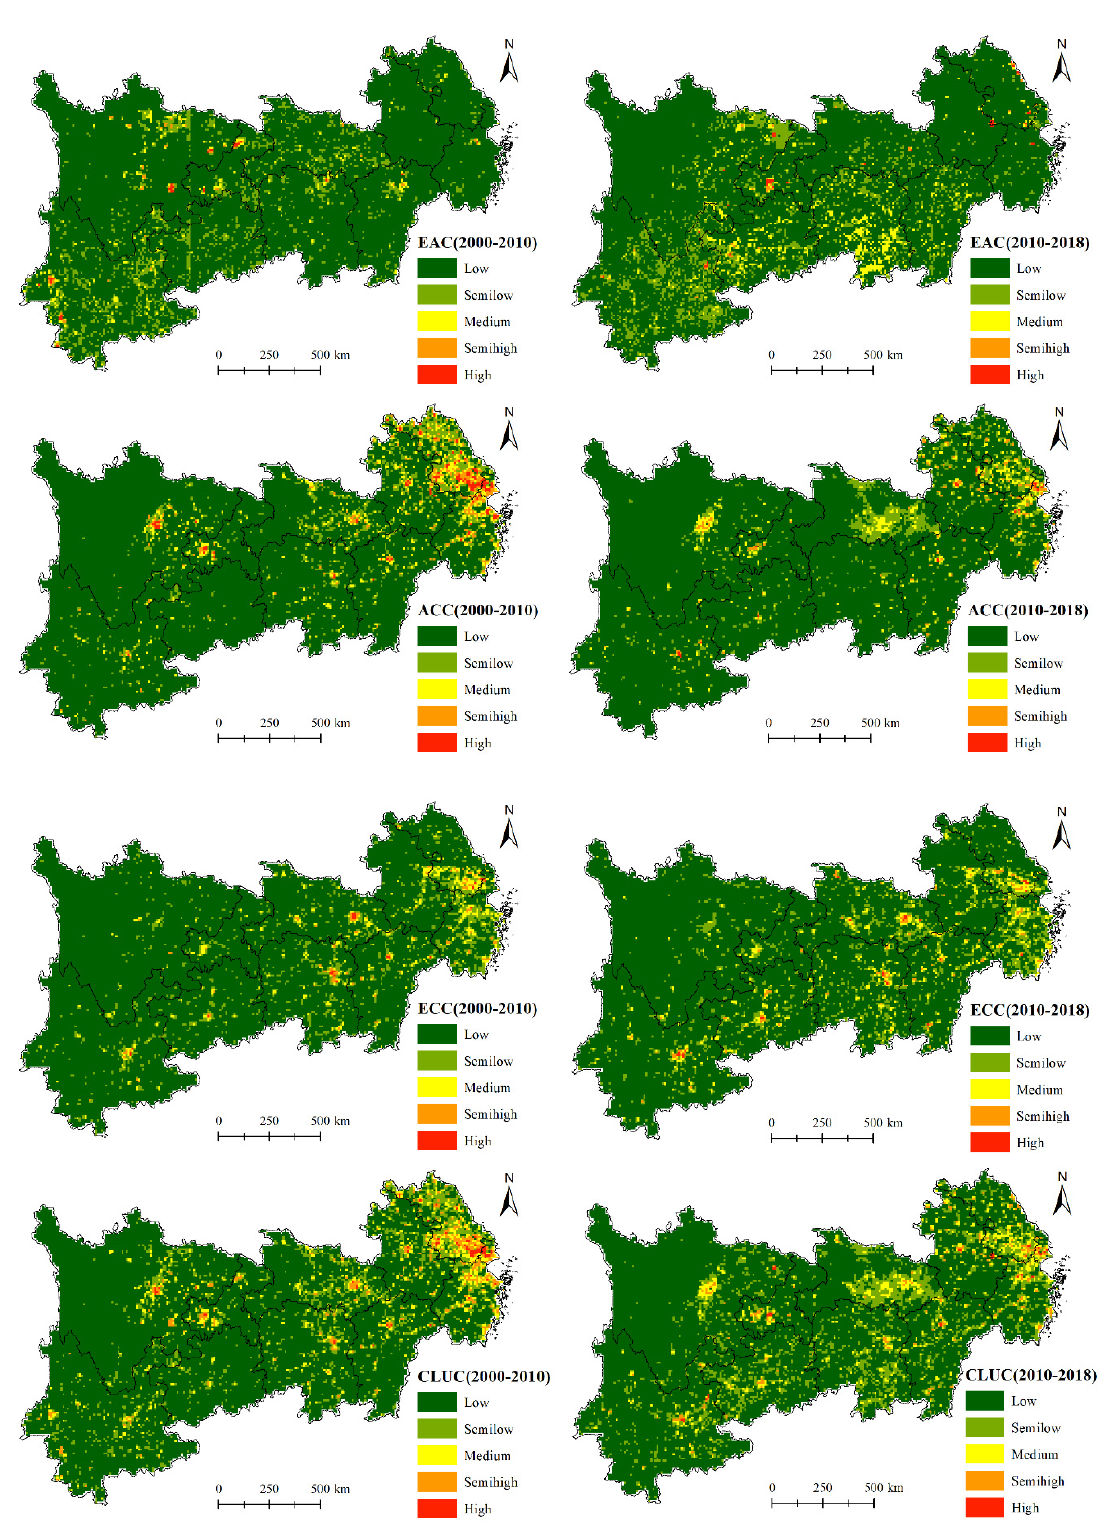
Figure 4. Spatial distribution pattern of land use conflict indicators during 2000–2010 and 2010–2018.